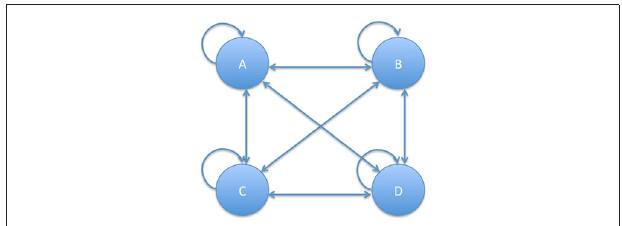
FIGURE 43 | Authors’ citation graph symmetric connected